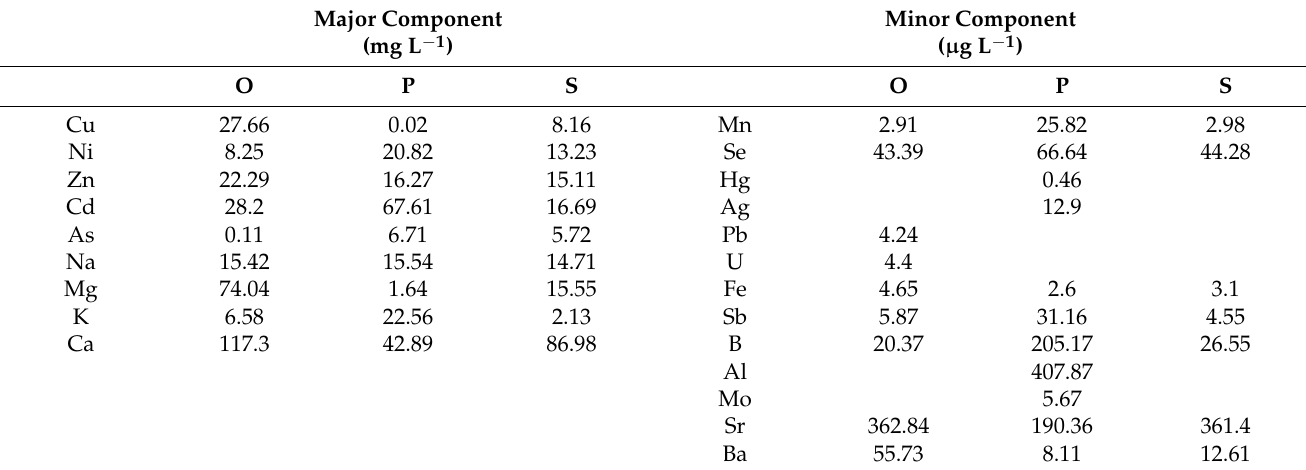
Table 1. Metal ions concentrations analyzed by ICP of three mining and metallurgical